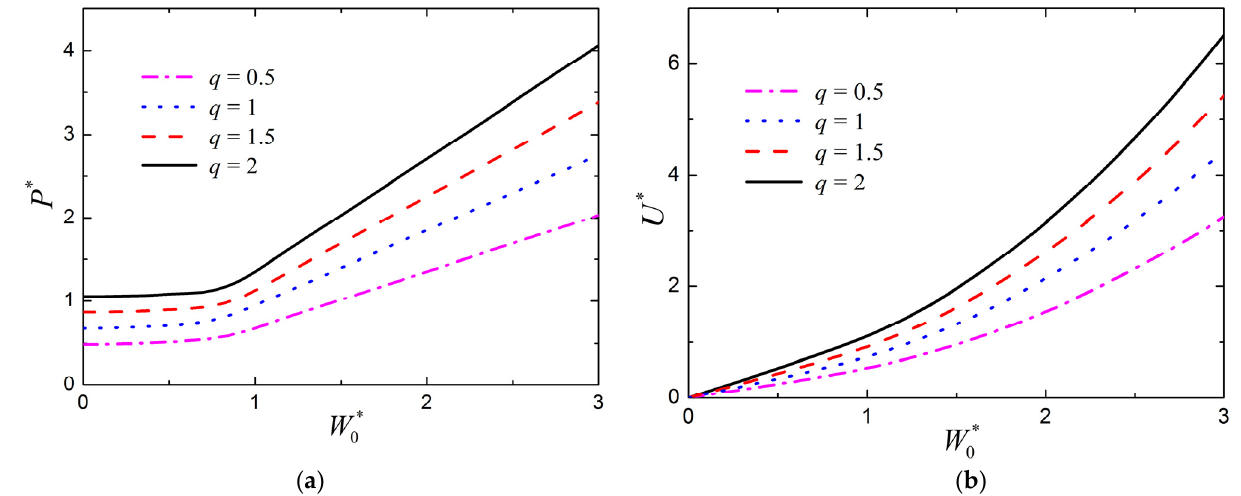
Figure 8. Influence of strength ratio of metal to composite layer q on the large deflection response of FML sandwich beams transversely loaded by a flat punch ( c = 0.03, a = 0.05, h f = 0.05, σ c = 0.1, n = 3, f = 0.6): ( a ) Load versus midspan deflection; ( b ) absorbed energy versus midspan deflection. Figure 9a,b show the effect of core strength on the normalized load P ∗ and the nor- malized absorbed energy U ∗ , as functions of the normalized midspan deflection W ∗ transversely loaded FML sandwich beams, respectively. Other parameters are given